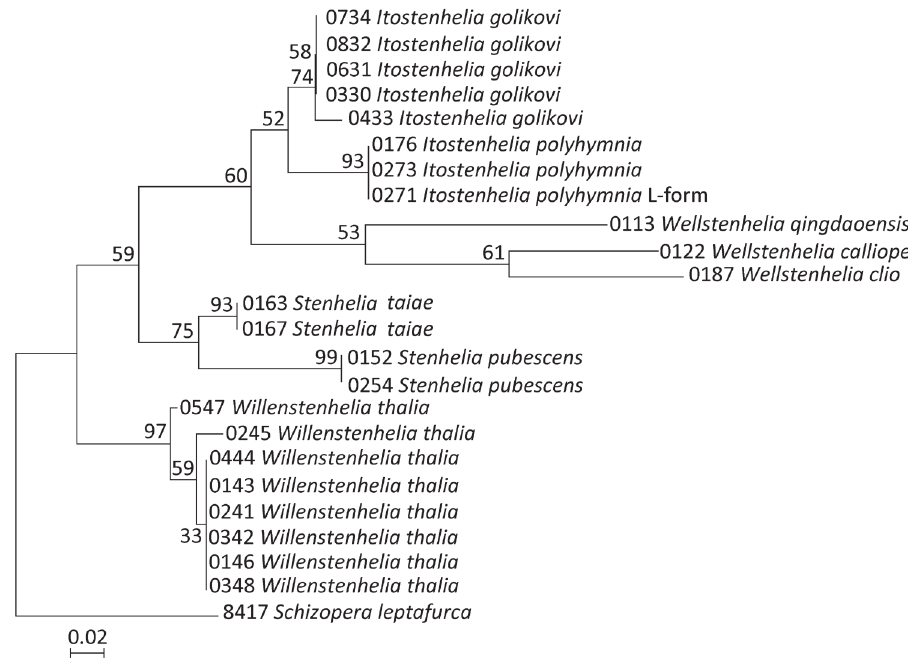
Figure 13. Maximum likelihood (ML) tree based on mtCOI sequence data of 23 stenheliin specimens from Gwangyang Bay (South Korea) and Posyet Bay (Russia), constructed using MEGA v 5.0.3 and an HKY+G model of evolution, with numbers on the branches representing bootstrap values from 500 pseudoreplicates. The tree is rooted with Schizopera leptafurca Karanovic & Cooper, 2012 from Western Australia. The cladogram is drawn to scale and the specimen codes correspond to those in Table